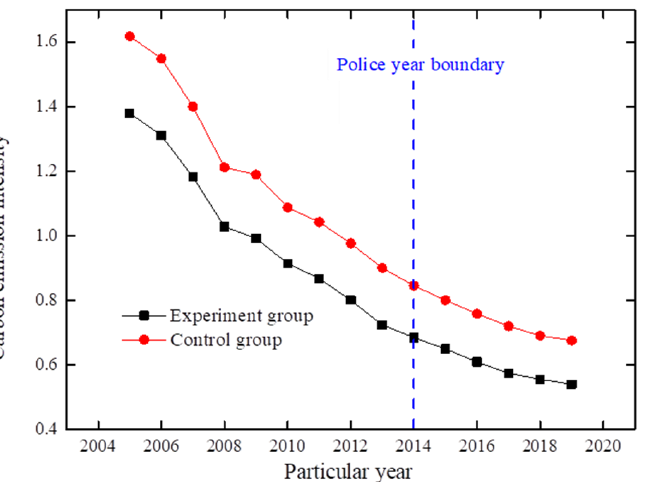
Figure 4. Trend chart of carbon emission intensity before and after carbon emission trading pilot policy. Table 8. Robustness test with different time